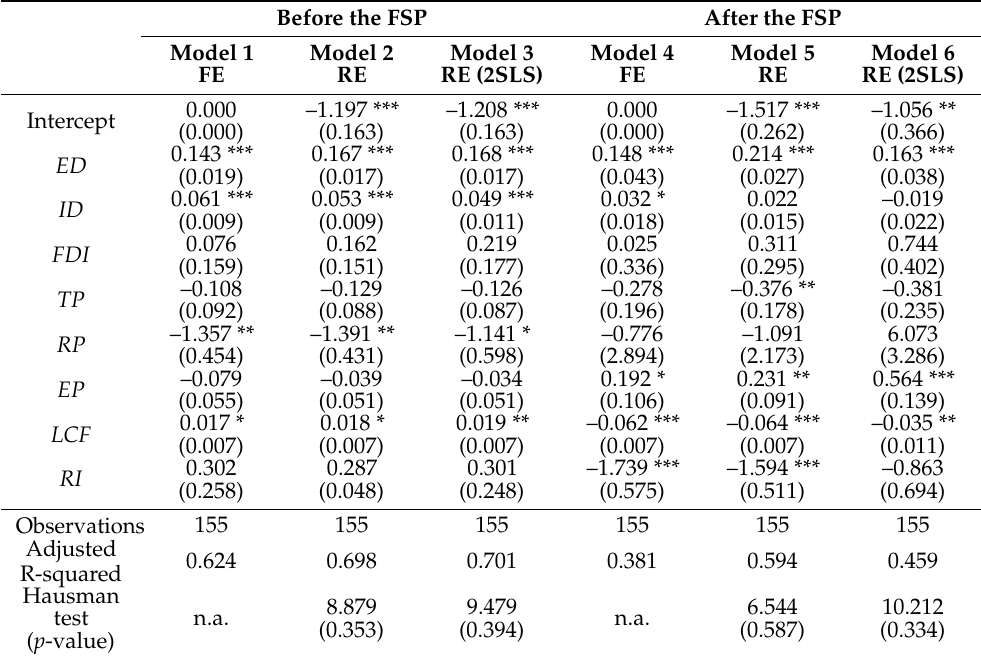
Table 2. Panel data regression results (fixed-effects (FE) and random-effects (RE)) and two-stage least squares (RE (2SLS)) estimation for the whole of China.